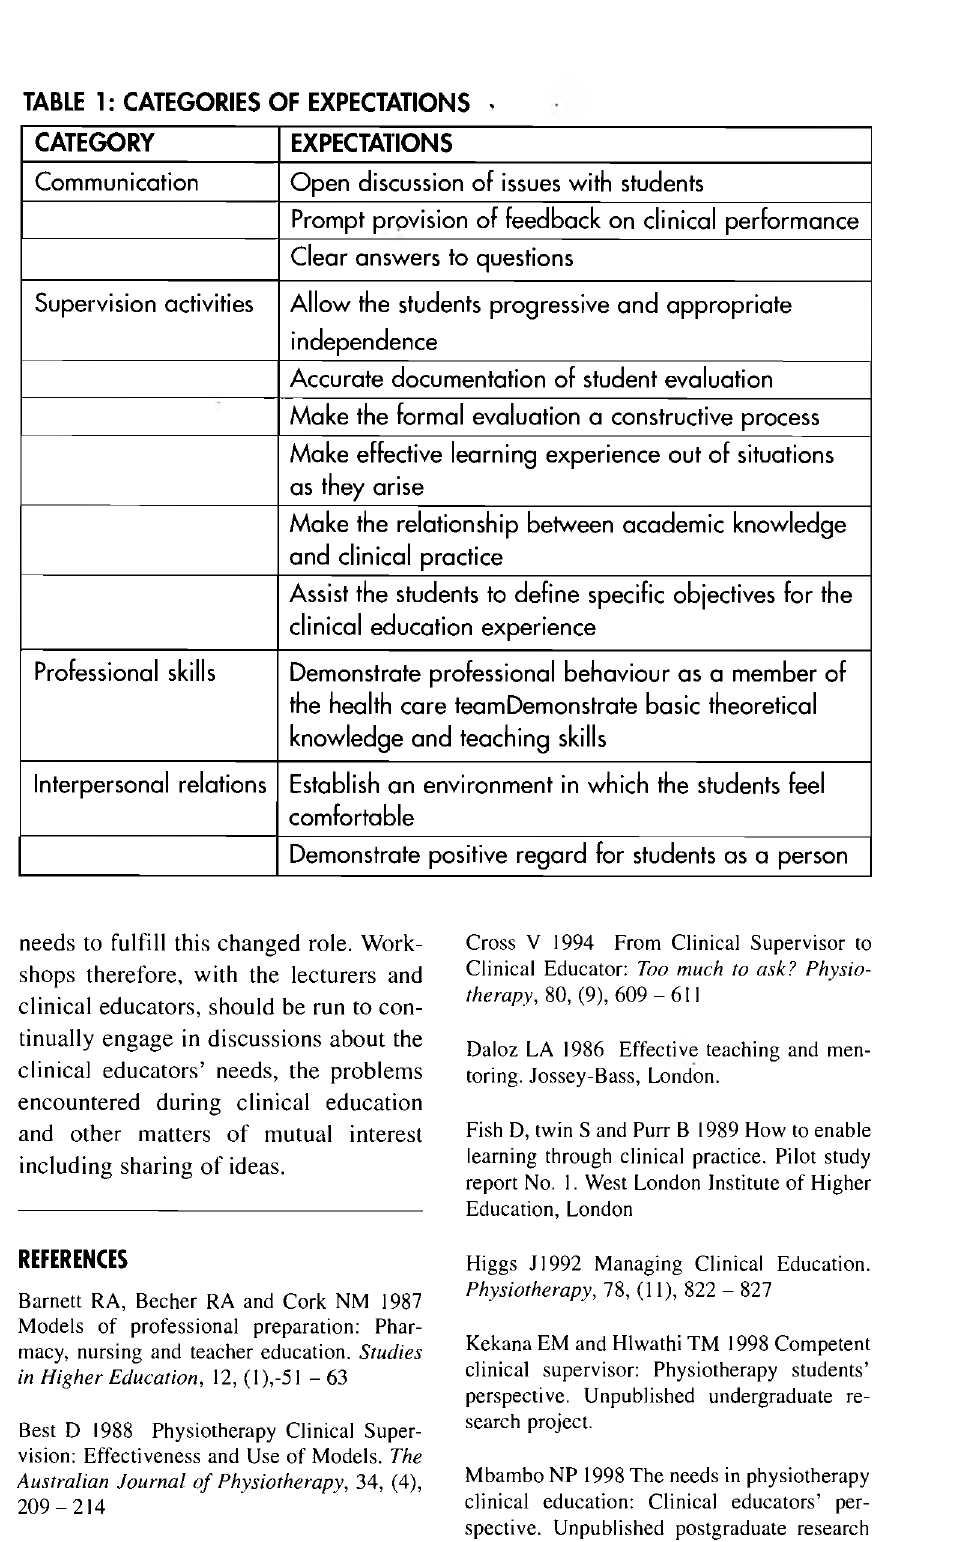
TABLE 1: CATEGORIES OF EXPECTATIONS